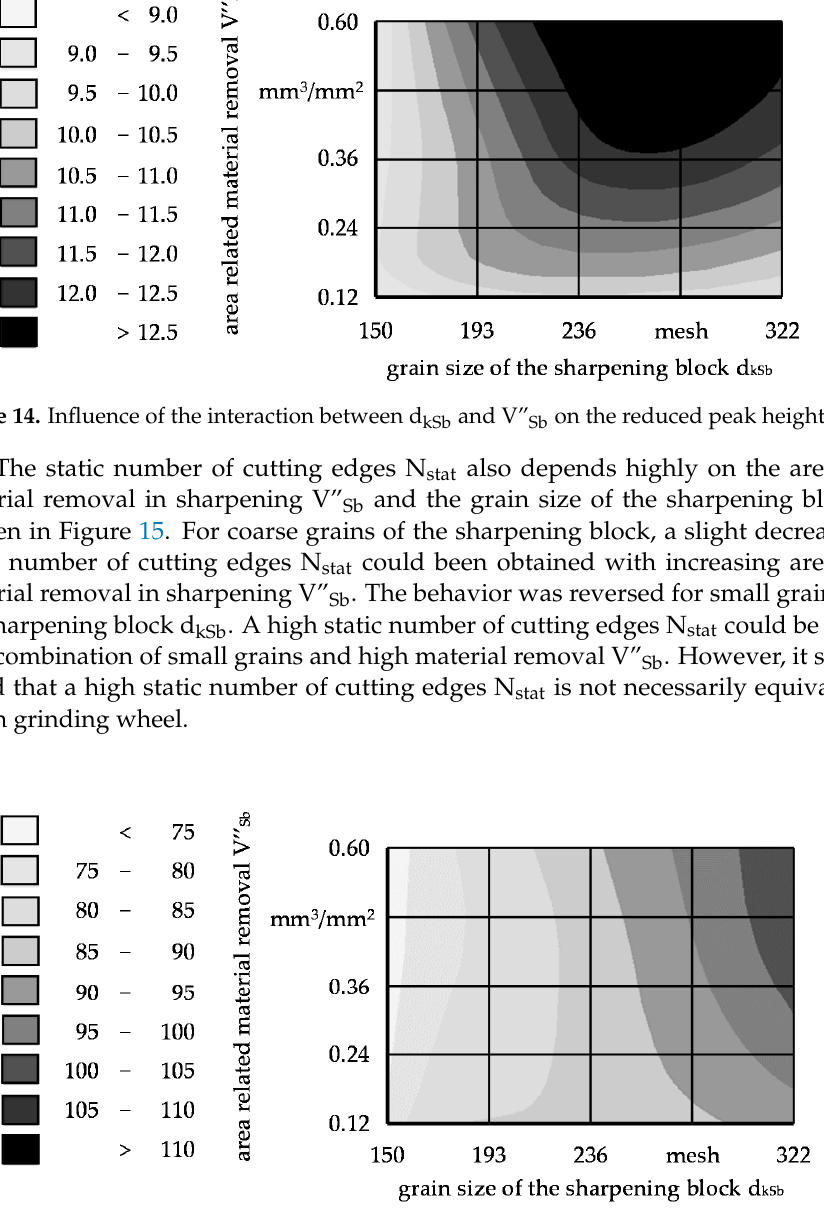
Figure 15. Influence of the interaction between d kSb and V’’ Sb on the static number of cutting edges N stat.